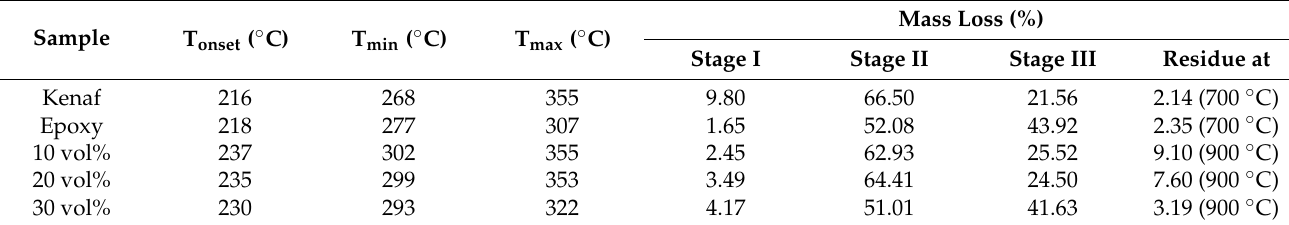
Table 2. Degradation temperatures and mass loss for kenaf fibers and